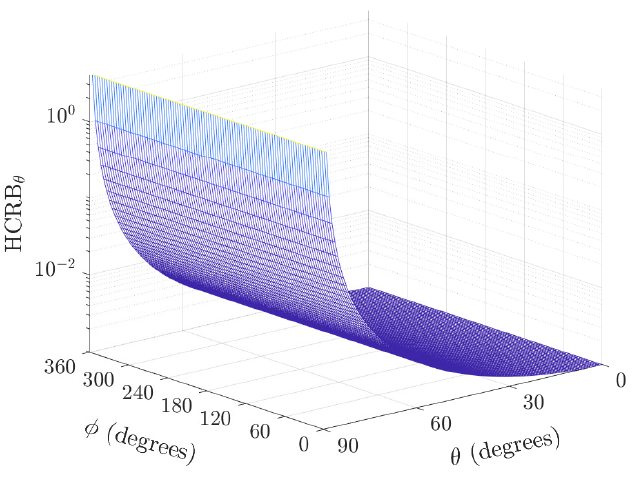
Figure 2. Plot of HCRB θ versus the direction of the arrival polar and azimuth angles for K = 100